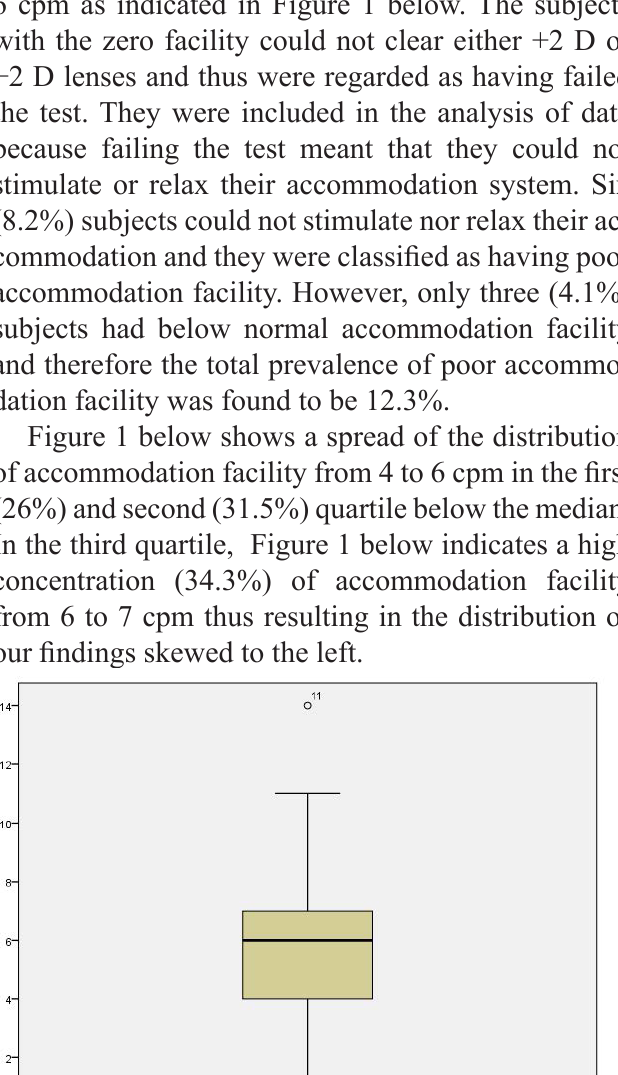
Figure 2 Distribution of amplitudes of accommodation for the right and left